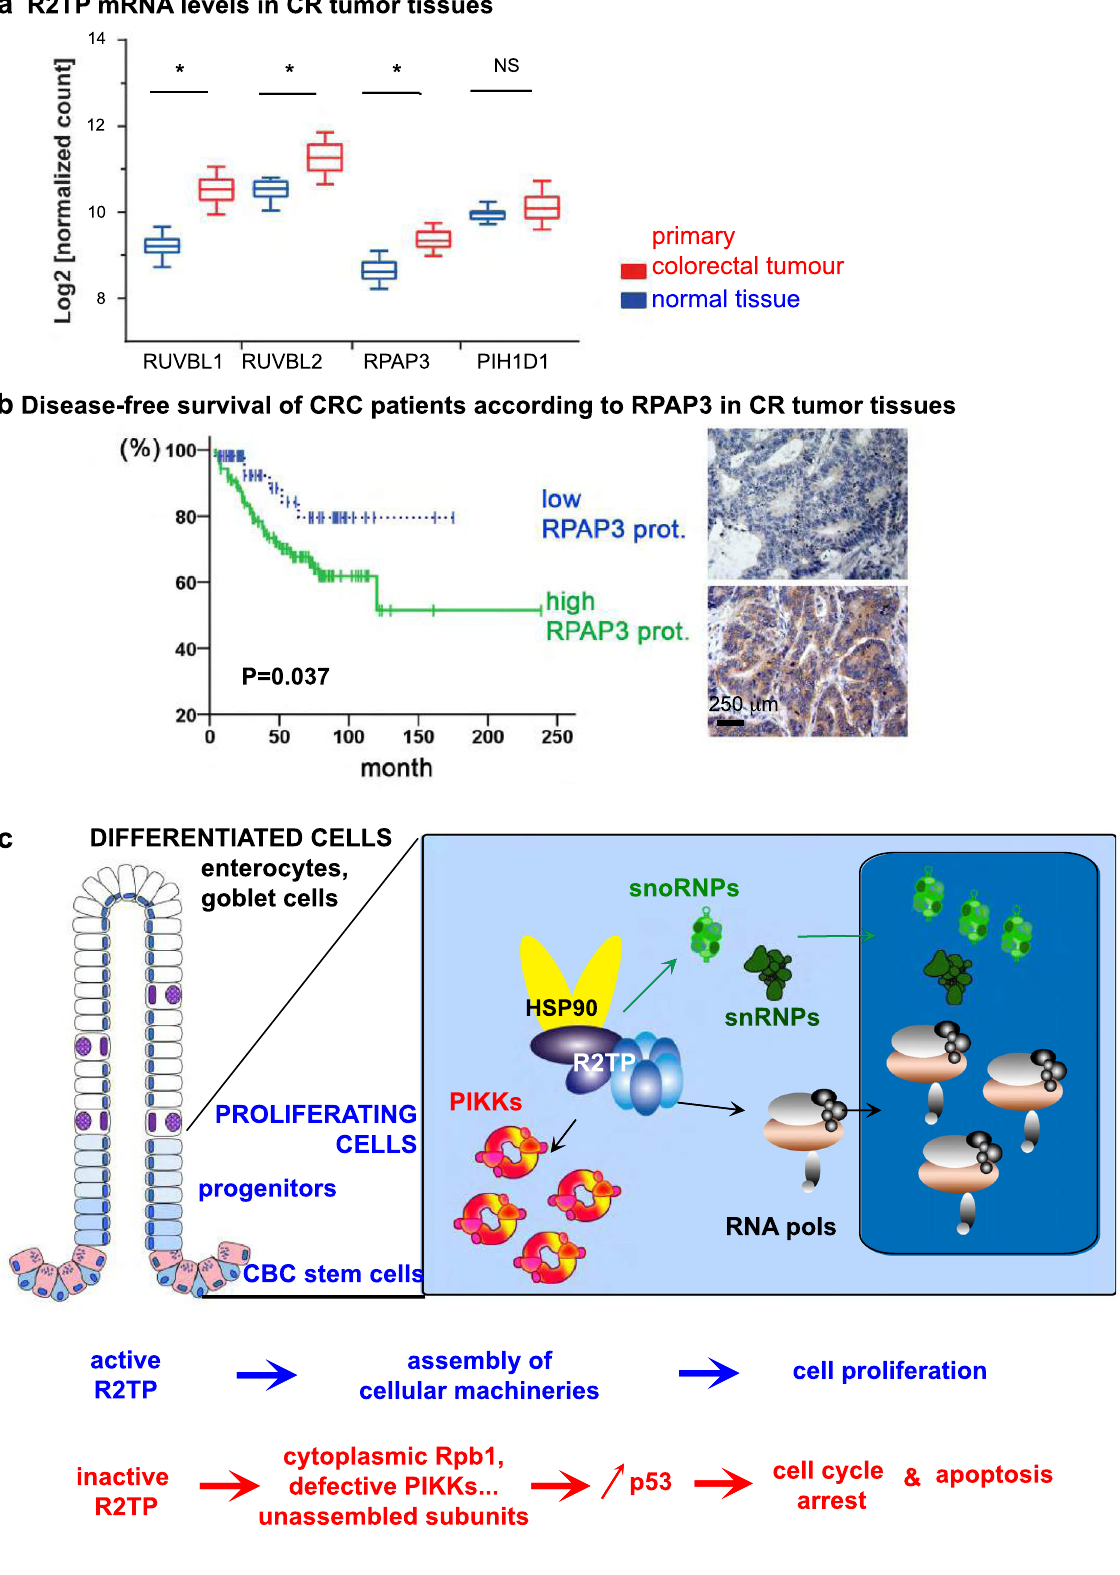
public and private cancer genomics data visualization and interpretation https:// xenabrowser.net/ 75 . One-way ANOVA test was performed using GraphPad Prism 5.0. For the outcome endpoints of human data, the DFS was de fi ned as the measure of time after treatment during which one of the following events occurred: relapse at local or distant sites, or intercurrent death without